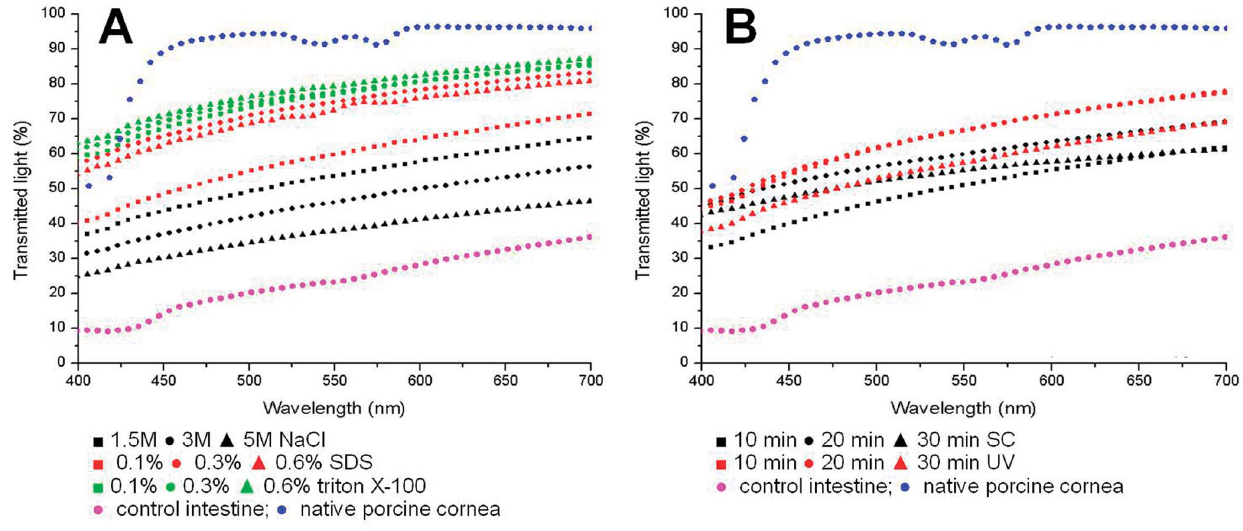
Figure 8. Light transmittance analysis of control and decellularized SI samples. Panel A corresponds to samples decellularized using chemical agents, whereas results of the application of physical decellularization methods are shown in panel B. Non-decellularized intestine and native porcine cornea are shown as controls.